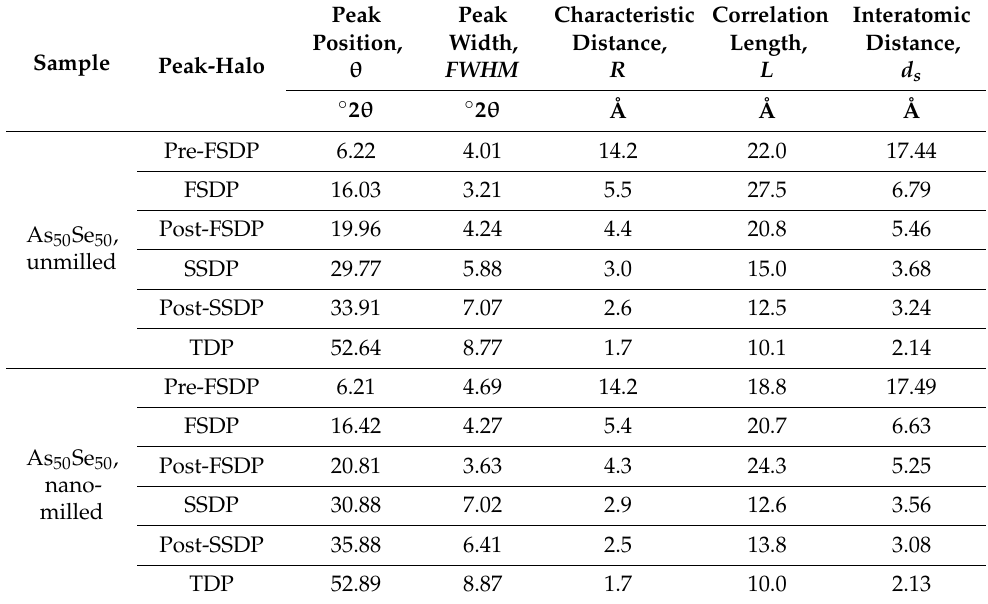
Table 1. Parameterization of diffuse peak-halos in MQ-derived (unmilled) and MM-derived (nanomilled)